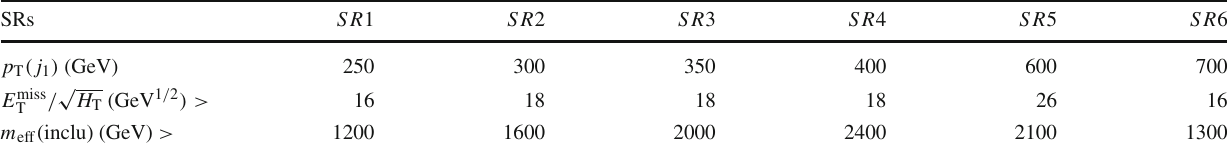
Table 1 Six signal regions are defined by the values of p T ( j 1 ) , m ef f ( inclu ) and E miss from the process pp → ˜ g ˜ g + X for the gluino coannihilation at the HE-LHC